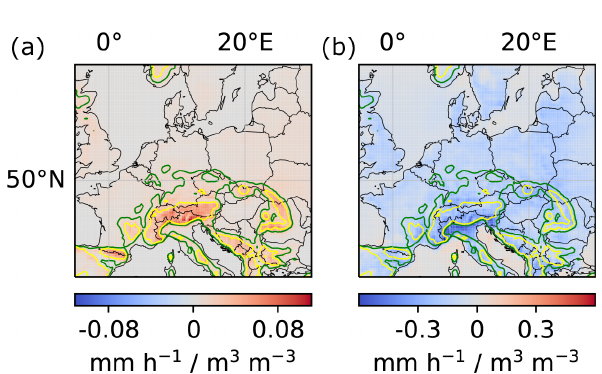
Figure A5. Sum of local and regional soil-moisture–convective- precipitation and soil-moisture–large-scale-precipitation couplings. (a) Sum of local couplings. (b) Sum of regional couplings. See Ap- pendix Fig. A6 for soil-moisture–convective-precipitation and soil- moisture–large-scale-precipitation couplings.